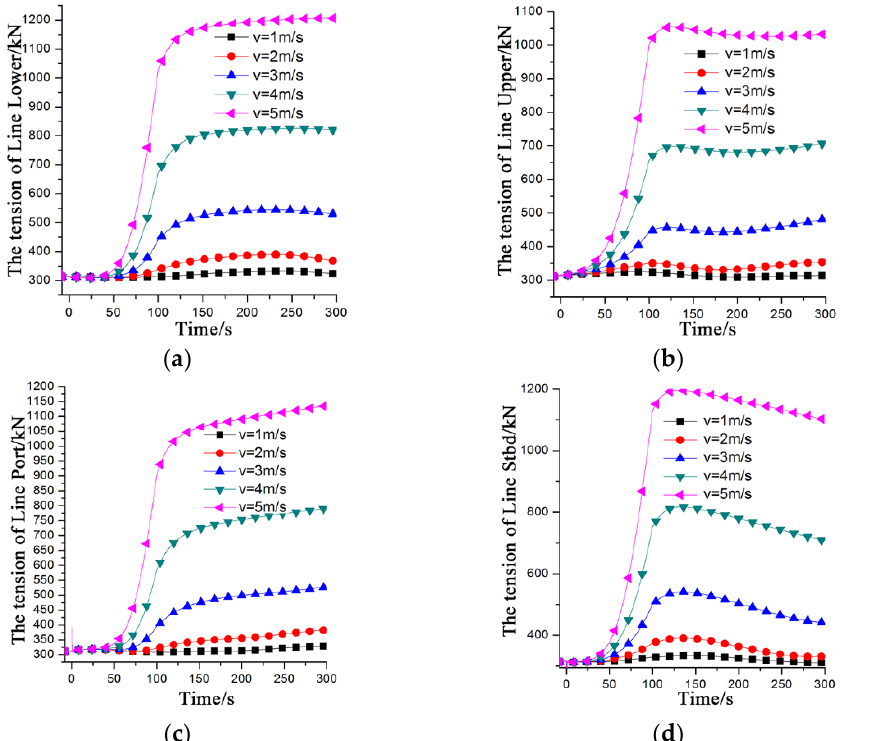
Figure 25. The time domain image of the cables’ tension of the rigid truss trawl system in rotating towing under fixed angular velocity: ( a ) Line Lower; ( b ) Line Upper; ( c ) Line Port; ( d ) Line Stbd.